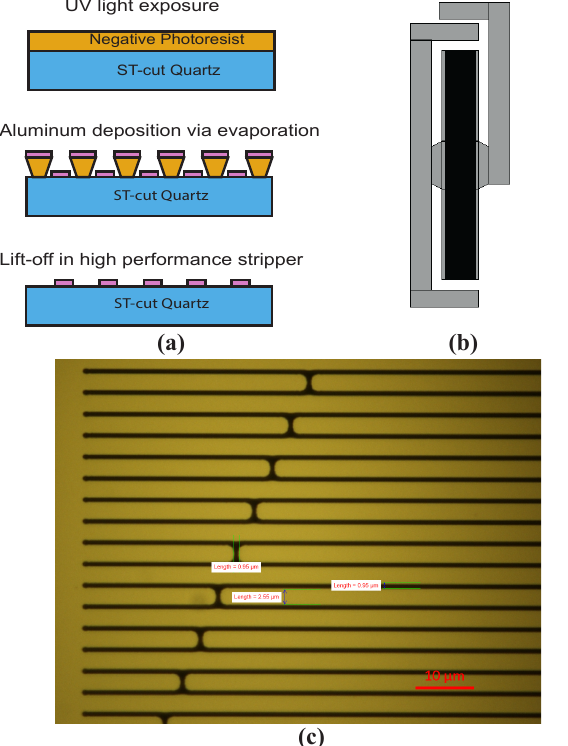
Figure 2. Resonator fabrication: ( a ) main process steps; ( b ) fabricated device featuring IDT, reflector gratings and electrode pads for electrical characterization; ( c ) IDT apodization features and critical